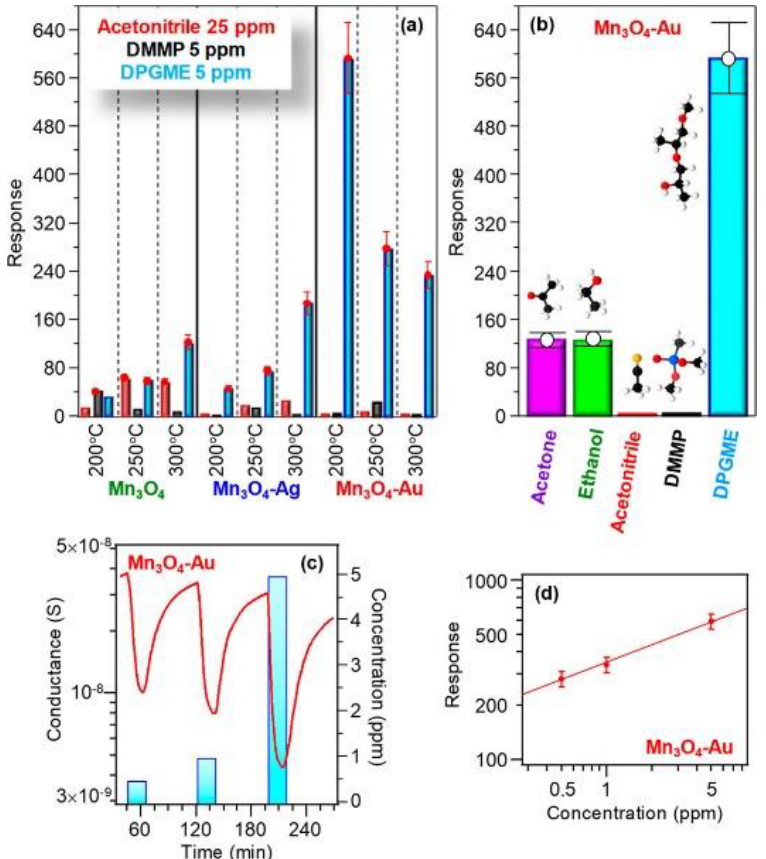
Figure 7. ( a ) Responses of Mn 3 O 4 , Mn 3 O 4 −Ag, and Mn 3 O 4 −Au sensors to selected concentrations of various chemical warfare agents (CWAs) at different operating temperatures. ( b ) Responses at 200 °C of Mn 3 O 4 −Au to various analytes (acetone, 100 ppm; ethanol, 50 ppm; acetonitrile, 25 ppm; dimethyl methyl phosphonate (DMMP), 5 ppm; di(propylene glycol) monomethyl ether (DPGME), 5 ppm). Dynamic response to DPGME ( c ) and response vs. DPGME concentration ( d ) for Mn 3 O 4 − Au at 200 °C. Reproduced with permission [71].